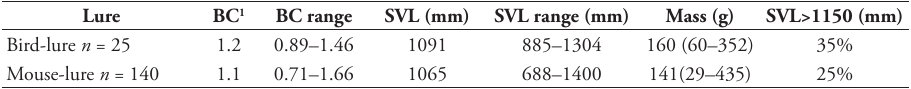
Table 1. Morphometrics of individual brown treesnakes ( Boiga irregularis ) trapped with live mouse- and/or live bird-lures based on first encounter presented as mean ± SE (range), Guam National Wildlife Refuge